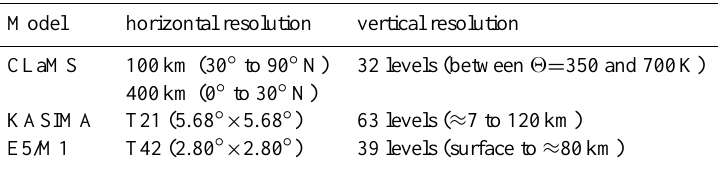
Table 2. Overview of model